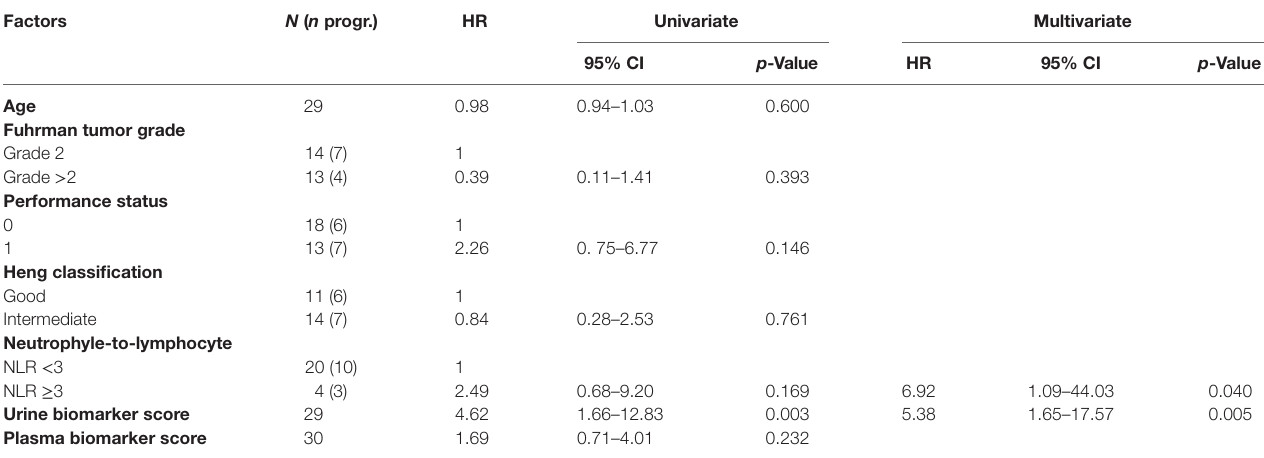
TaBle 2 | hazard ratio (hr) for clinical factors and PFs (patients with missing scores were omitted). Factors N ( n